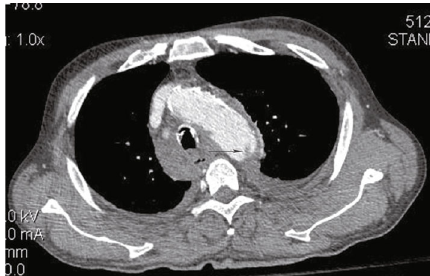
Figure 1: Preoperative CTA showed transection of the distal aortic arch.